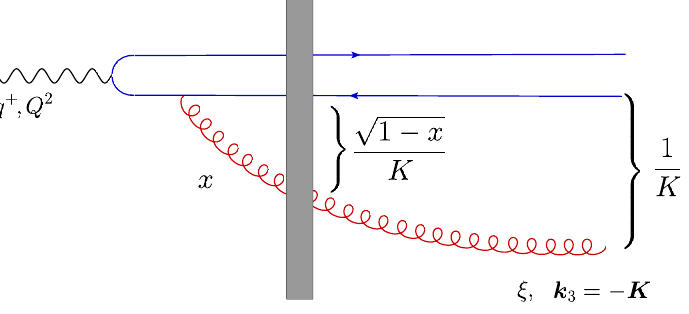
Figure 6 . Pictorial illustration of the q ¯ qg Fock state in the regime where the gluon formation time is relatively large, of the order of the coherence time of the virtual